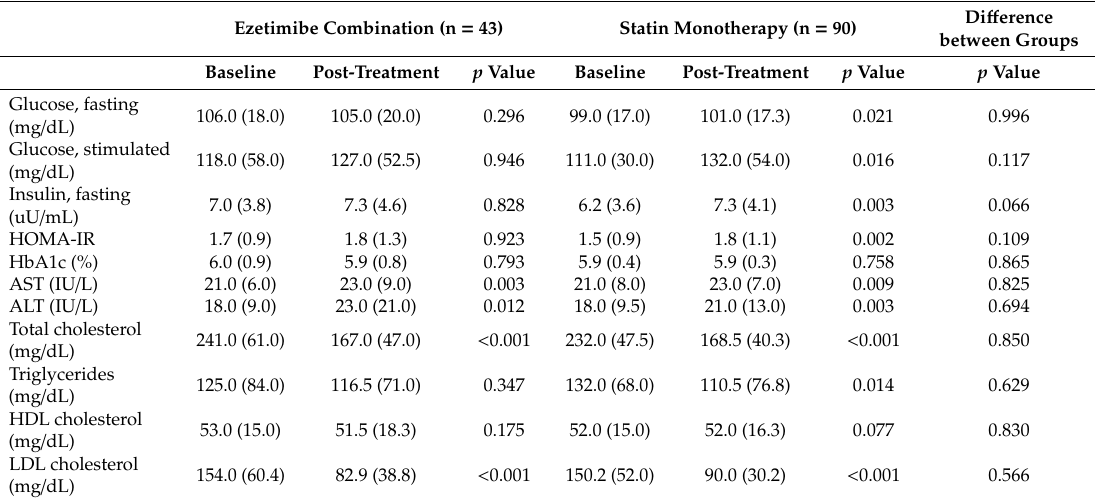
Di ff erence between Groups